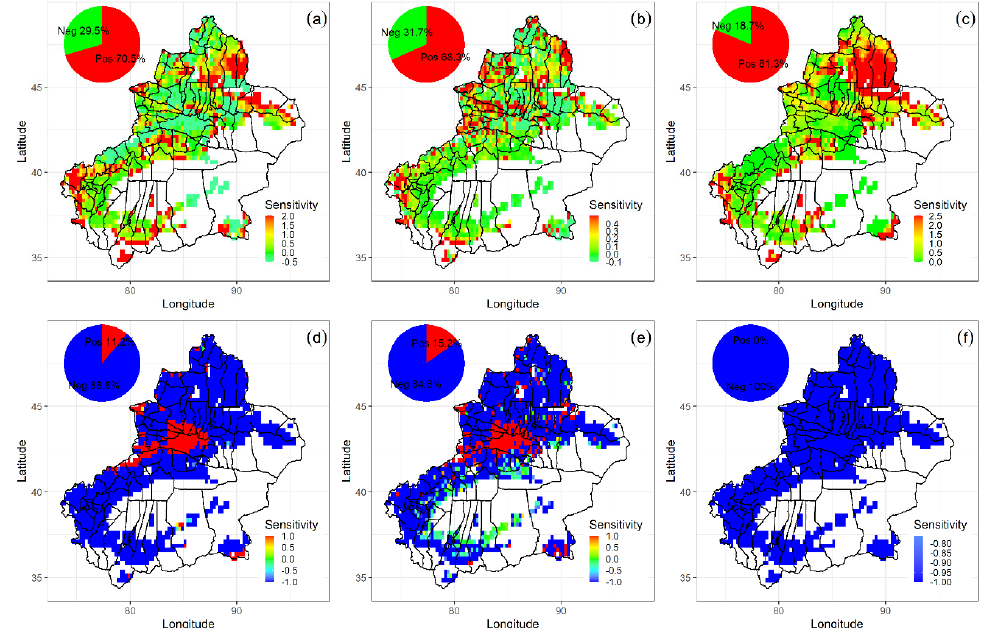
Figure 9. WUEs sensitivity coefficient to precipitation and temperature ( a ), ( b ), and ( c ) respectively represent the sensitivity coefficient of temperature to eWUE, tWUE, and pWUE; ( d ), ( e ), and ( f ) respectively represent the sensitivity coefficient of precipitation to eWUE, tWUE, and pWUE; the upper left illustration shows the proportion of positive ( Pos ) and negative ( Neg ) sensitivities.